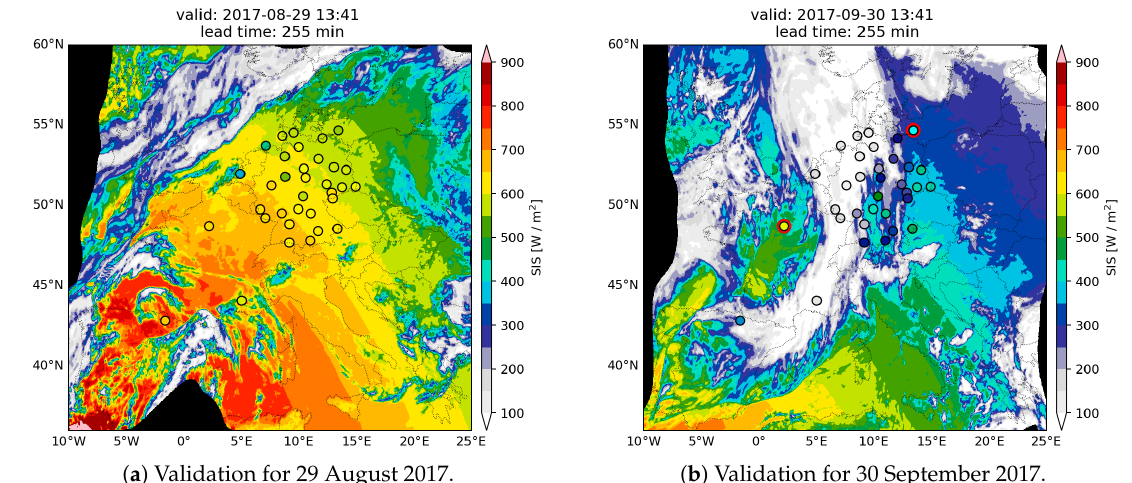
Figure 7. Validation of the solar surface irradiance nowcasting with ground stations by BSRN (Baseline Surface Radiation Network) and DWD (Deutscher Wetterdienst) for 29 August 2017 ( a ) and 30 September 2017 ( b ). Depicted is the nowcasting of SIS as contour plot and the measured value of the ground stations is given in the black circles. The colorbar matches both figures. The forecast time equals 255 min. The red circles in ( b ) mark the stations Arkona and